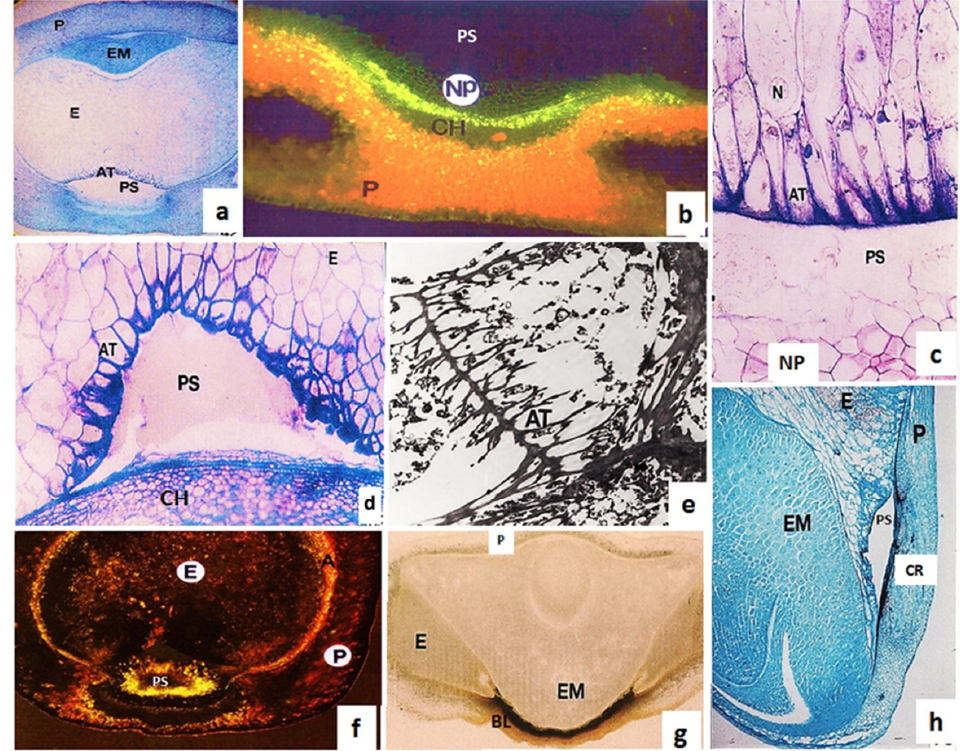
Figure 7. Anatomy and histochemistry transport structures (a) Low magnification view of caryopsis 10 DAF showing the position of embryo and endosperm in relation to placental sac and aleurone transfer layer. 40x. (b) Free-hand transverse sections excited with blue light. Chlorophyll autofluoresces in red in pericarp region. Yellow fluorescence between chalazal and nucellar projection is due to the presence of lipids in the pigment layer. 180x. (c) T.S. of 5-day-old caryopsis. Cells between nucellar projection and aleurone transfer cells are lysed to create the placental sac. Aleurone transfer cells show wall thickenings. 320x. (d) 15- day-old caryopsis; thin plastic section near crease region showing large placental sac and aleurone transfer cells. 100x. (e) TEM view of cell wall ingrowths in periclinal walls of aleurone transfer cells in caryopsis 8 DAF. 10,500x. (f) T.S. of caryopsis 25 DAF revealing prominent pigment layer (yellow fluorescence due to lipids) as the placental sac begins to shrink. Lipid in aleurone layer also fluoresces. Stained with Nile blue A, excited with blue light. 40x. (g) 30-day-old unstained caryopsis section showing black layer. 30x. (h) 20-day-old grain in wax embedded L.S. showing the small placental sac between embryo and chalazal complex. 40x. (A, aleurone; AT, aleurone transfer cell; BK. Black layer; CH, chalazal complex; CR, crease region; E, endosperm; EM, embryo; N, nucleus; NP, nucellar projection; P, pericarp; PS, placental